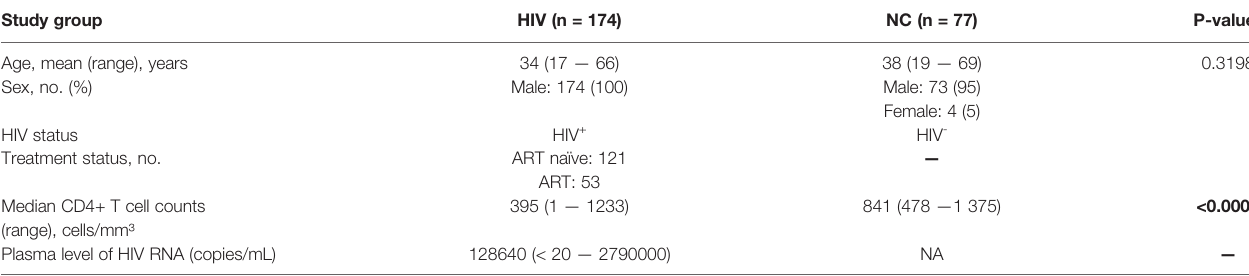
TABLE 1 | Characteristics of clinical study participants. Study